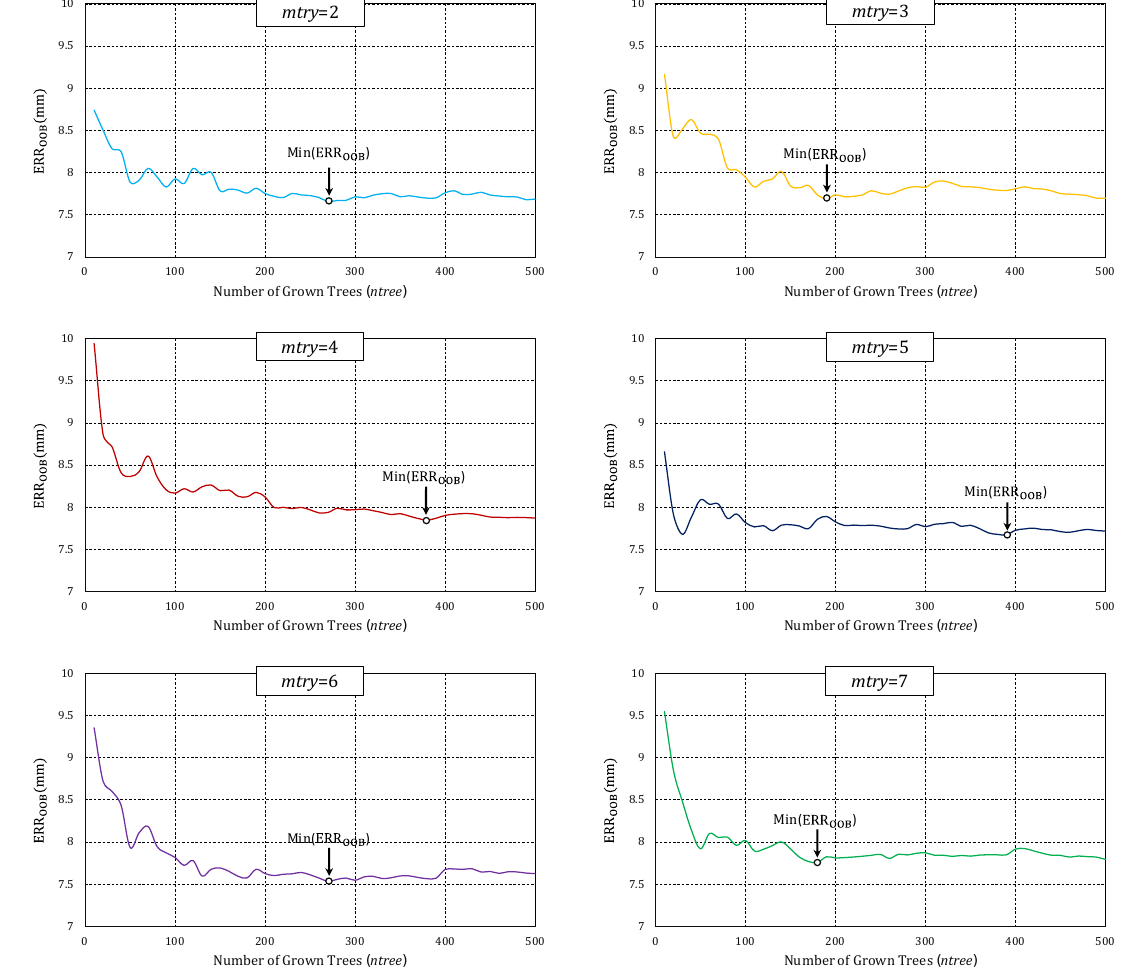
Figure 6. vs. for different values. Arrow shows optimal number of grown tree that produced least out- of-bag estimate of error rate.